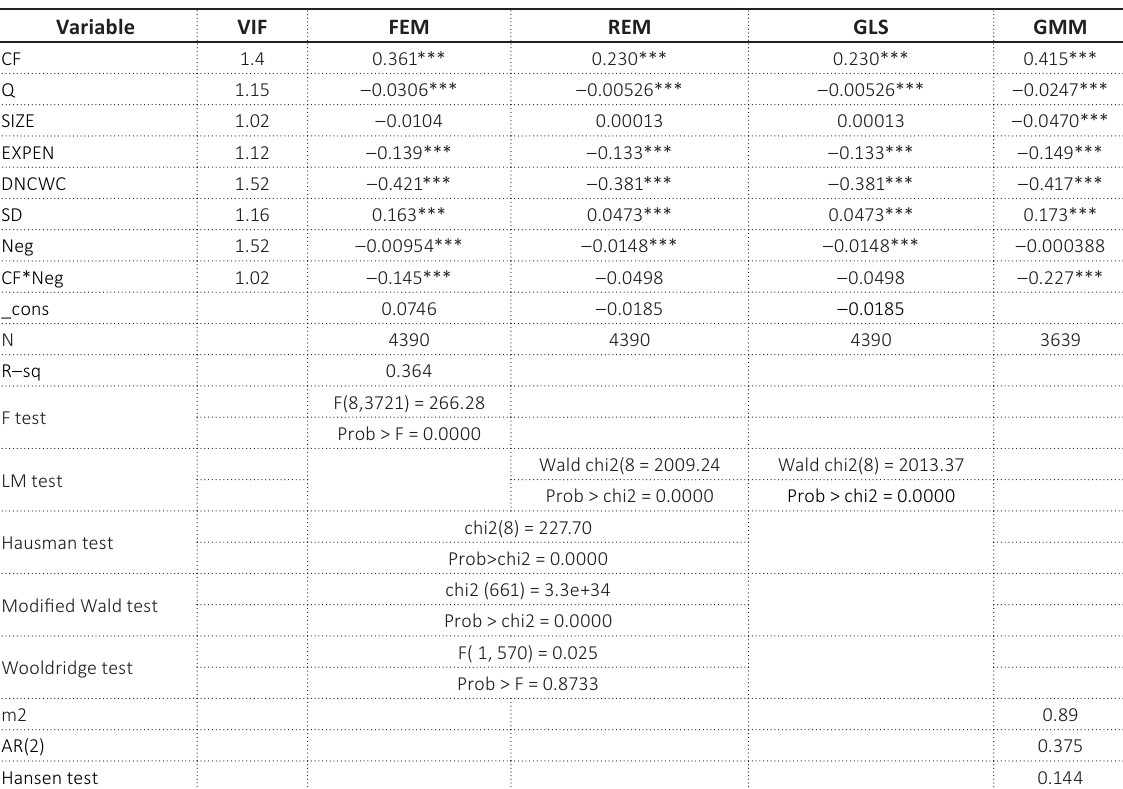
Table 5. Regression results of model